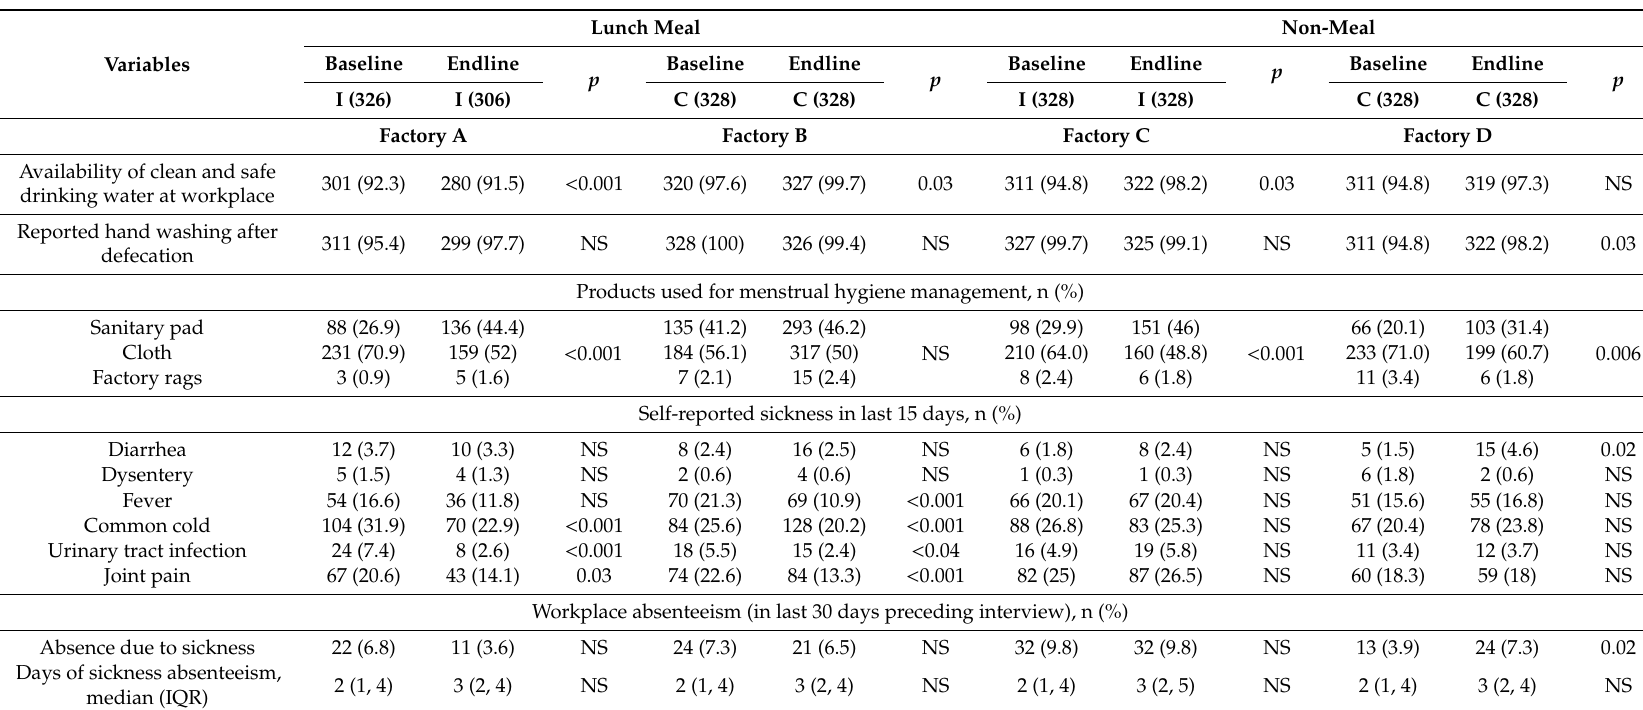
Table 4. Changes in water, sanitation, and personal hygiene practices, self-reported sickness, and workplace absenteeism from baseline to endline.